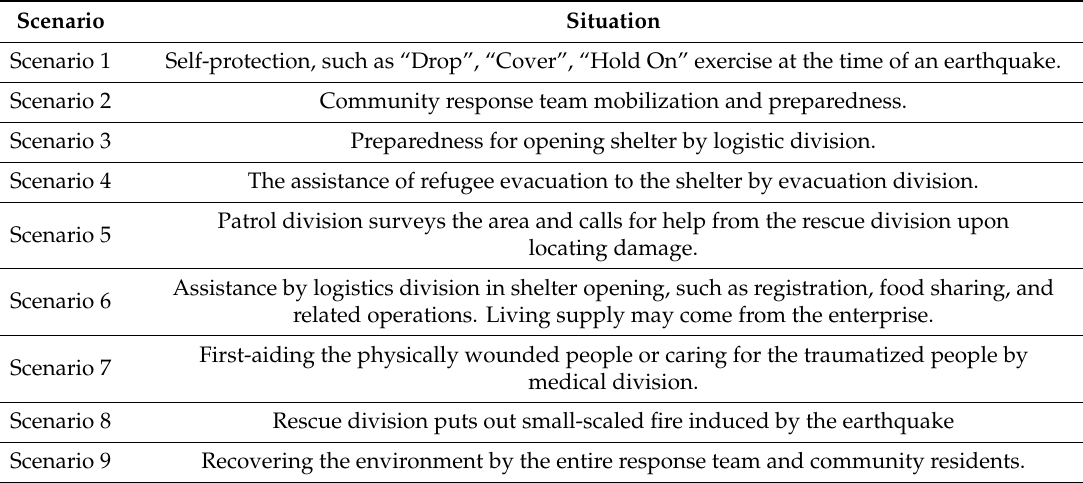
Table 2. Typical Scenarios Designed for Earthquake Drill in